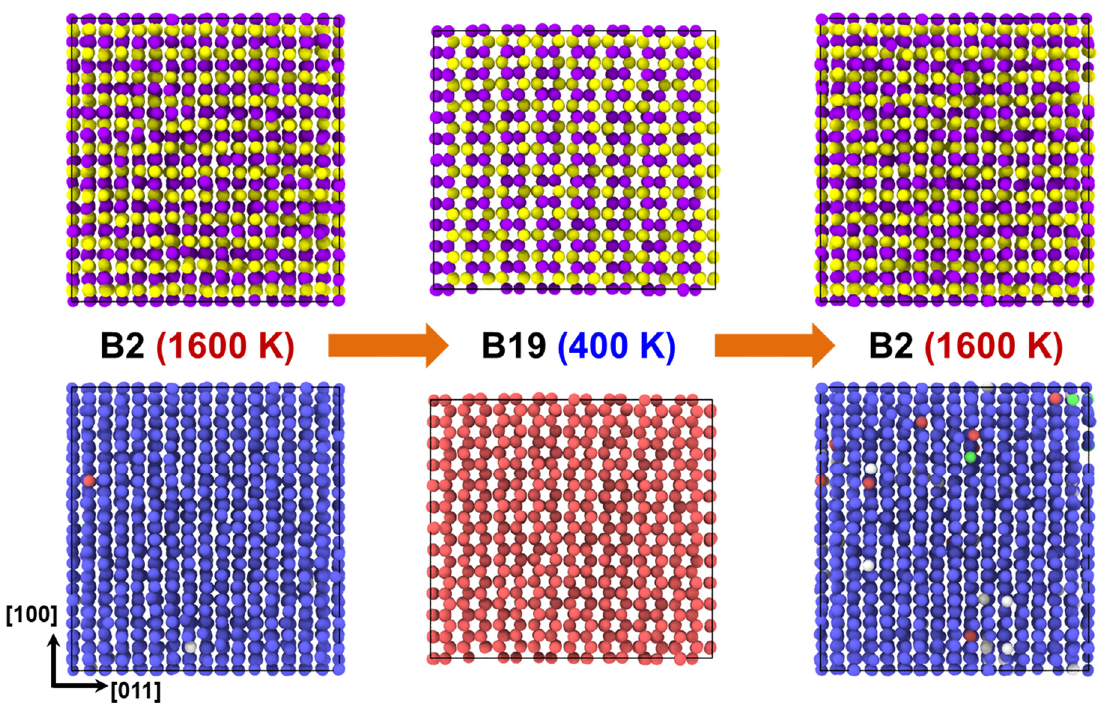
Figure 7. Atomic configurations of equiatomic PtTi obtained by the MD simulations performed using the present interatomic potential. The configurations at 1600 K (before cooling), 400 K (after cooling), and 1600 K (after reheating) are illustrated in sequence. In the upper row, the purple and yellow atoms denote Pt and Ti, respectively. The PTM method [95] was used to identify the B2 austenite and B19 martensite structures, whose atoms are colored blue and red, respectively, in the lower row of the figure.